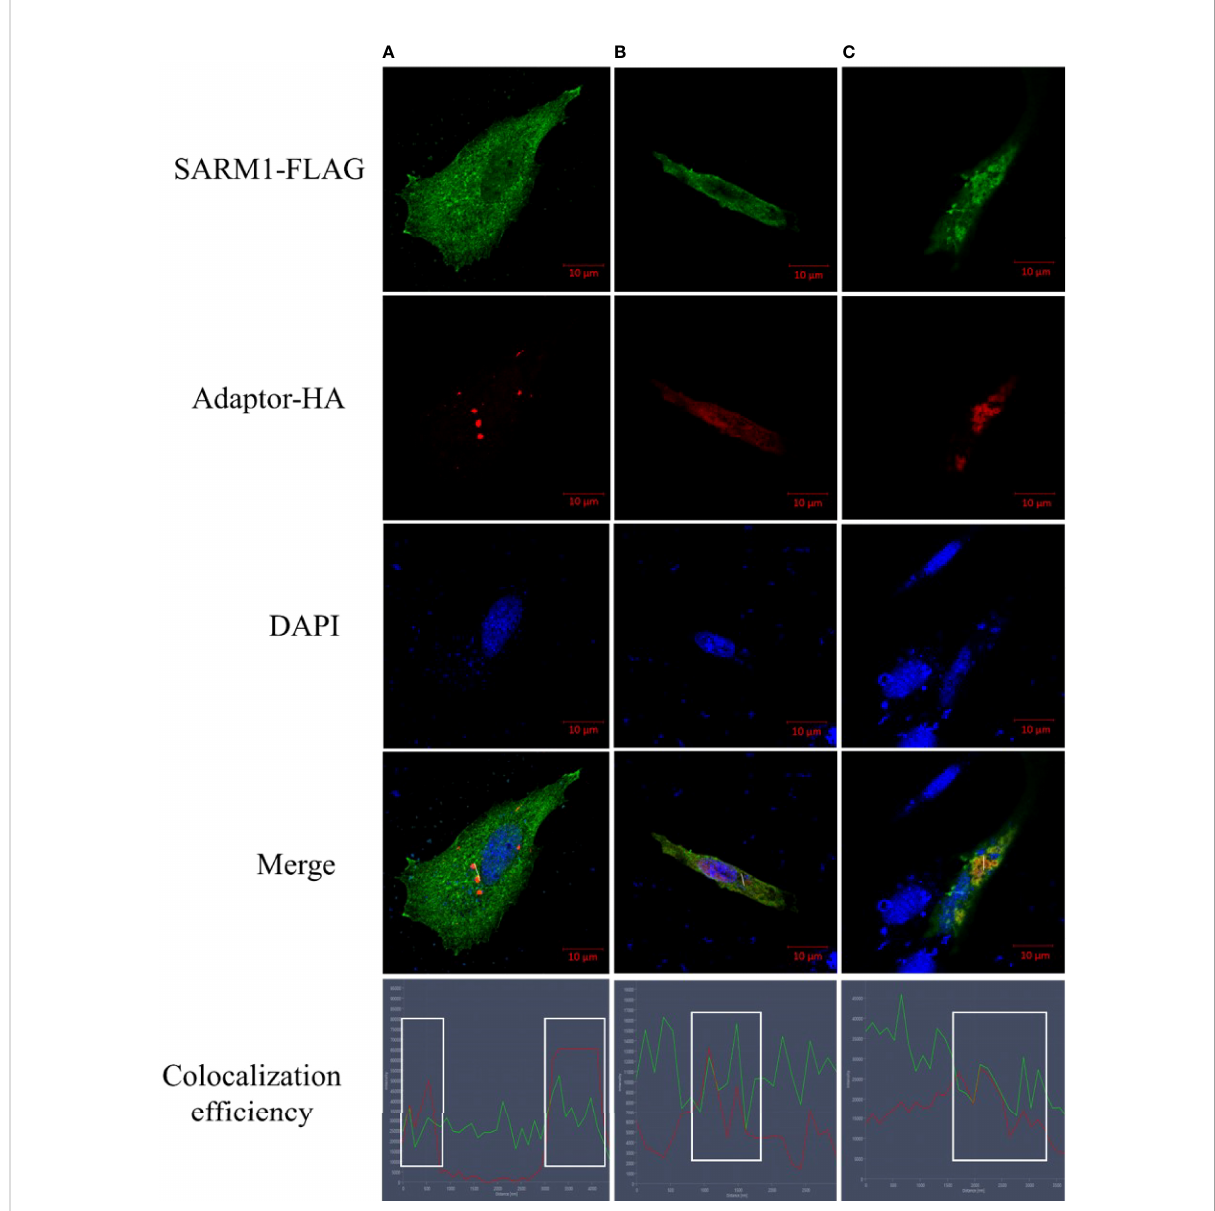
FIGURE 10 Colocalization of OnSARM1 with other TLR adaptors. THK cells were co-transfected with OnSARM1-3×FLAG and HA-tagged (A) OnTRIF, (B) OnTIRAP or (C) OnMyD88 expression plasmids, respectively. The cells were fi xed 48 h after transfection, followed by staining with anti-FLAG or anti-HA antibodies. Alexa Flour ™ 488 goat anti-mouse IgG and Alexa Flour ™ 568 goat Anti-rabbit IgG were used to visualize FLAG tag (green) or HA tag (red), respectively. Cells were then stained with VECTASHIELD Antifade Mounting Medium containing DAPI to visualize nucleus (blue). Images were captured using confocal microscopy (Zeiss LSM 880 with Airyscan). Colocalization ef fi ciency was quanti fi ed by observing the overlap of fl uorescence intensity peaks along the white line by line scan analysis pro fi les (ZEISS ZEN 2.6 (blue edition)